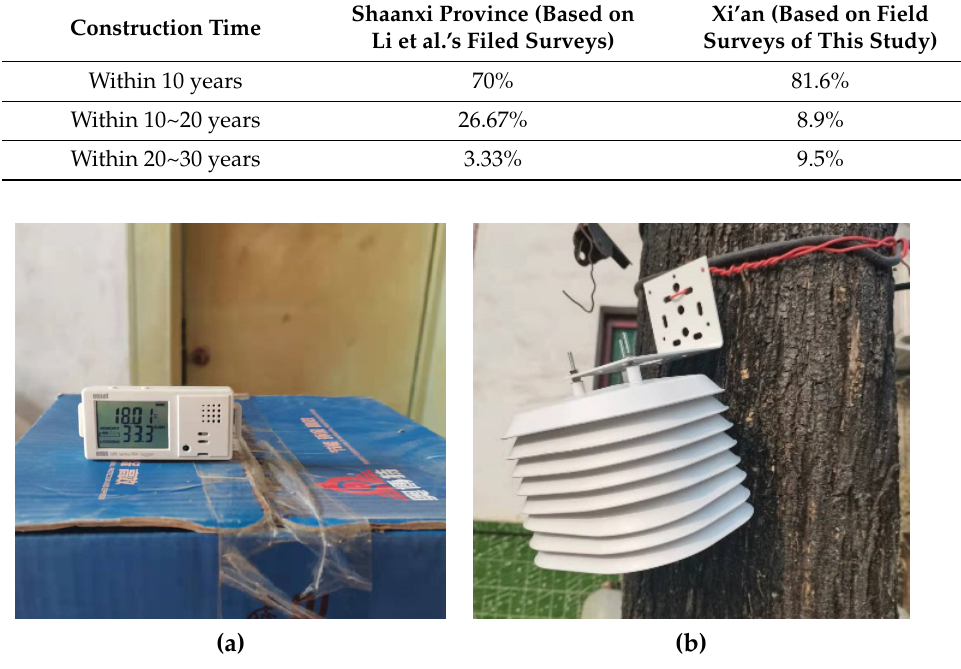
Figure 7. Temperature and relative humidity measurement: ( a ) Indoor; and ( b ) Outdoor.